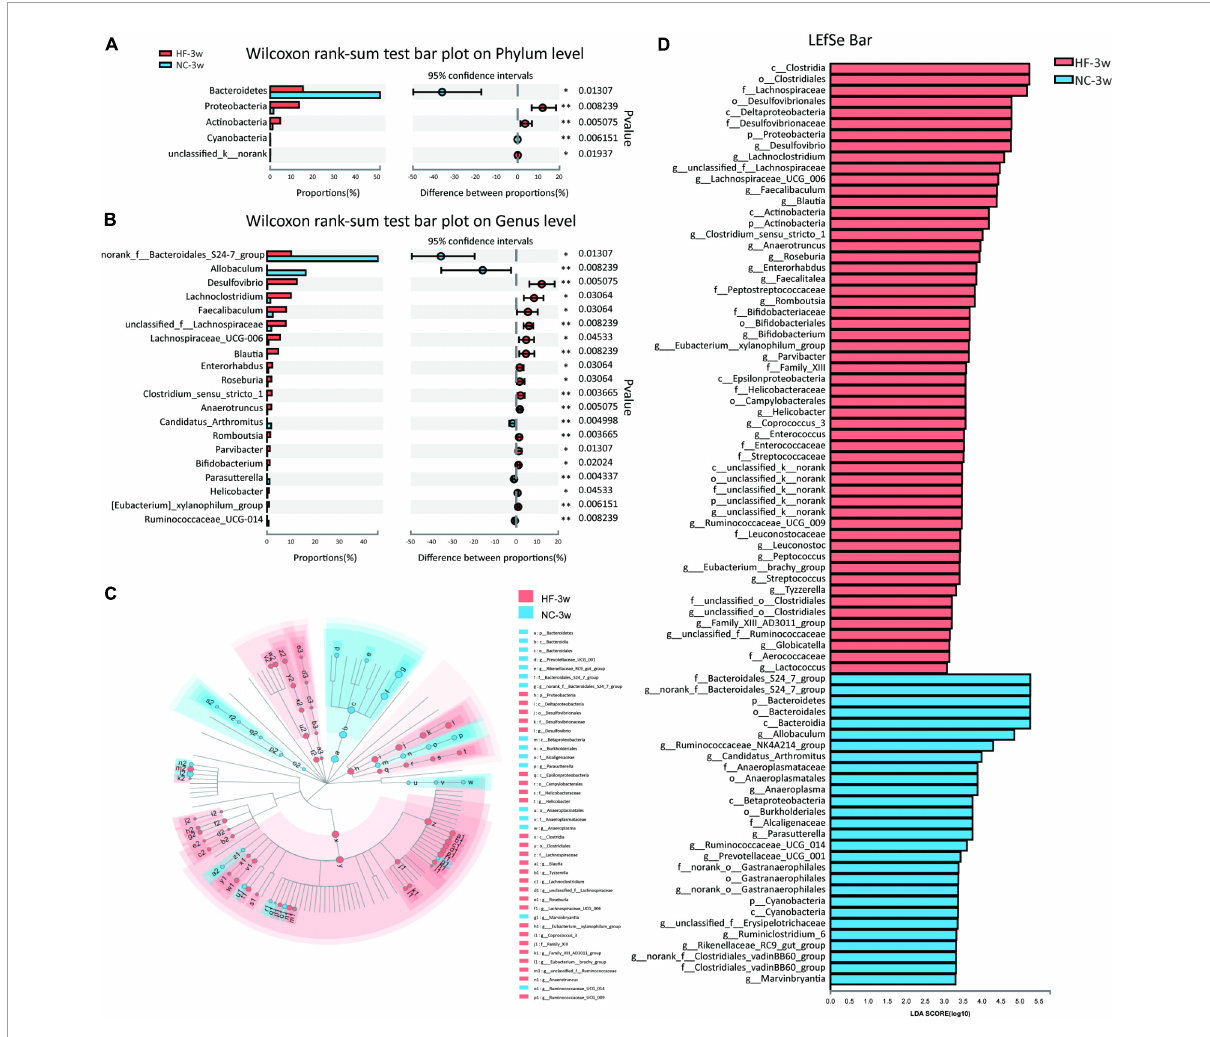
FIGURE3 Key bacteria were altered by the maternal HF diet in offspring at weaning. (A) Column chart of species abundance at the phylum level. (B) Column chart of top 20 species with significant differences at the genus level. (C,D) LEfSe analysis of the gut microbiota from the phylum level to the genus level, with LDA values of 2.0 (NC-3w, n = 6; HF-3w, n = 6). ∗ p < 0.05, ∗∗ p < 0.01 vs. NC-3w. NC, normal chow diet; HF, high-fat diet. LEfSe, linear discriminant analysis (LDA) effect